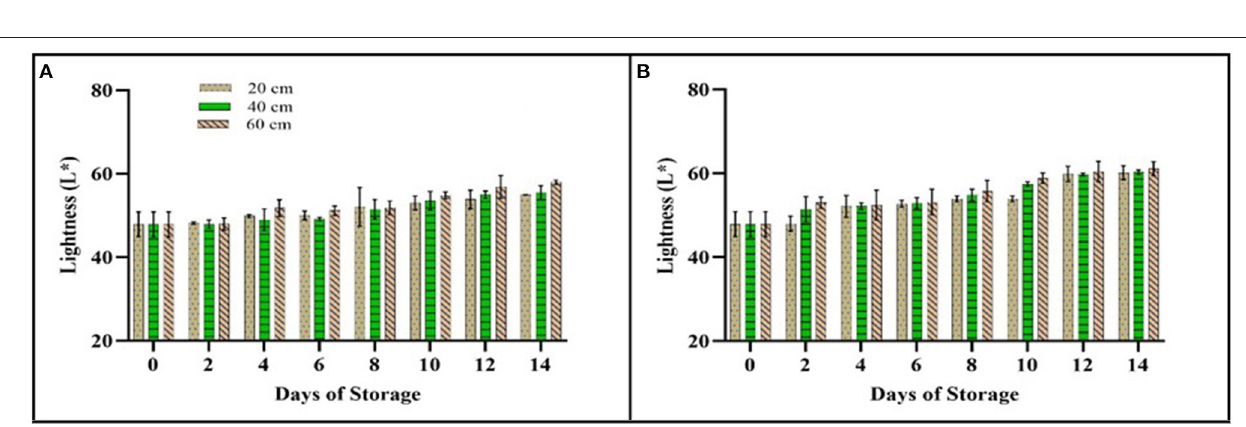
FIGURE 4 | L* value of pear impacted at different drop heights (20, 40, and 60cm) during 14 days at (A) 10 ◦ C and (B) 22 ◦ C storage conditions. The data were expressed in mean ± standard deviation. Error bars represent the standard deviation (S.D.) of the mean values ± S.D. of 18 readings per three